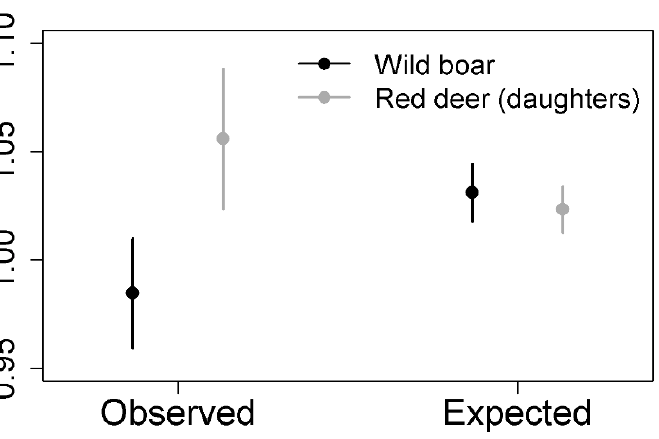
Figure 3. Mean and 95% confidence intervals for observed and expected heterozygosity of fetuses in wild boar and red deer females that produced daughters. Expected heterozygosity was obtained after simulating random mating for each species. See description of the analysis in Table 2.